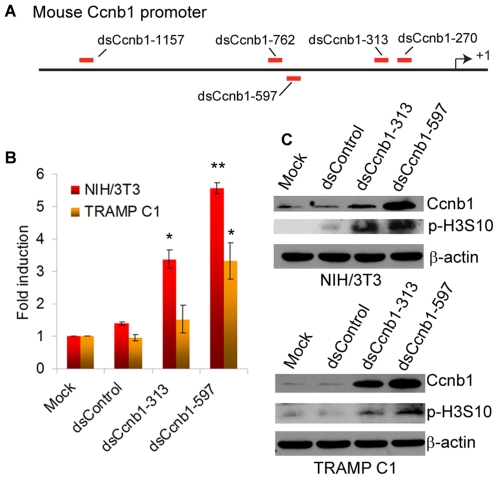
Ccnb1 activation in mouse cells by promoter-targeting saRNAs.
A. A schematic representation of the mouse Ccnb1 promoter. Indicated is the transcription start site (+1) and locations of the target sites for each putative saRNA. B. saRNAs were transfected into mouse NIH/3T3 and TRAMP C1 cells at 50 nM concentrations for 5 days. Ccnb1 mRNA levels were determined by real-time RT-PCR and normalized to β-actin levels. Results are mean ± SEM of 3 independent experiments. Statistical significance is indicated (* p<0.05, ** p<0.01) as compared to mock treatments. C. NIH/3T3 and TRAMP C1 cells were transfected as in B. Levels of Ccnb1 protein and phospho-histone H3 at serine 10 (p-H3S10) were determined by immunoblot analysis. Representative immunoblots are shown from 3 independent experiments.